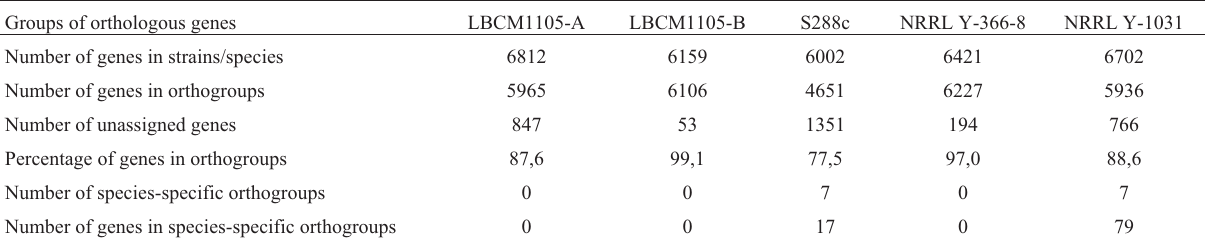
Table 1 - Comparison of groups of orthologous genes between W. anomalus LBCM1105 with two annotation strategies A) Augustus, B) BRAKER2, W. anomalus NRRL Y-366-8, W. ciferrii NRRL Y-1031 and S. cerevisiae S288c. Groups of orthologous